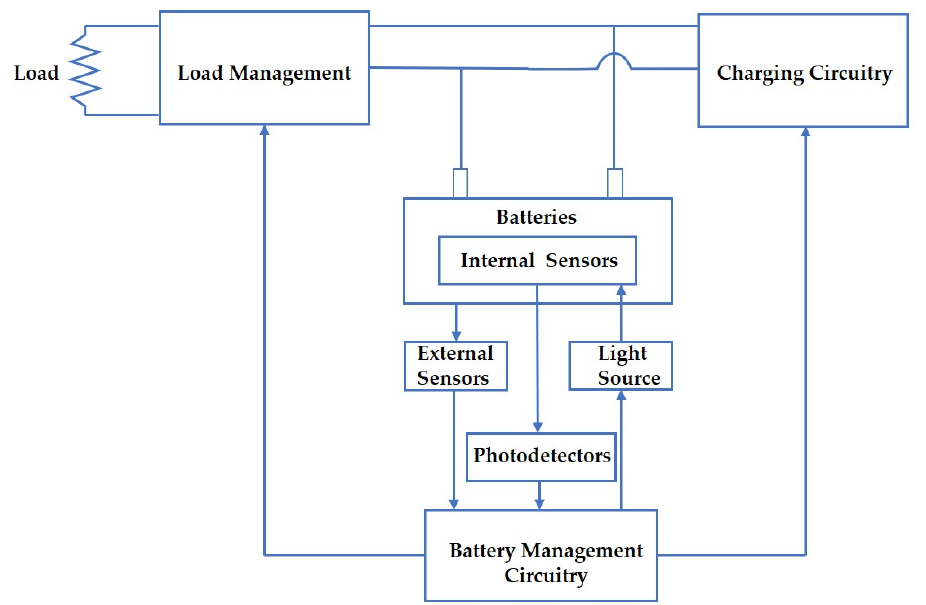
Figure 12. Block diagram of the battery management system with FBG internal sensors and low-cost photodetectors [165].